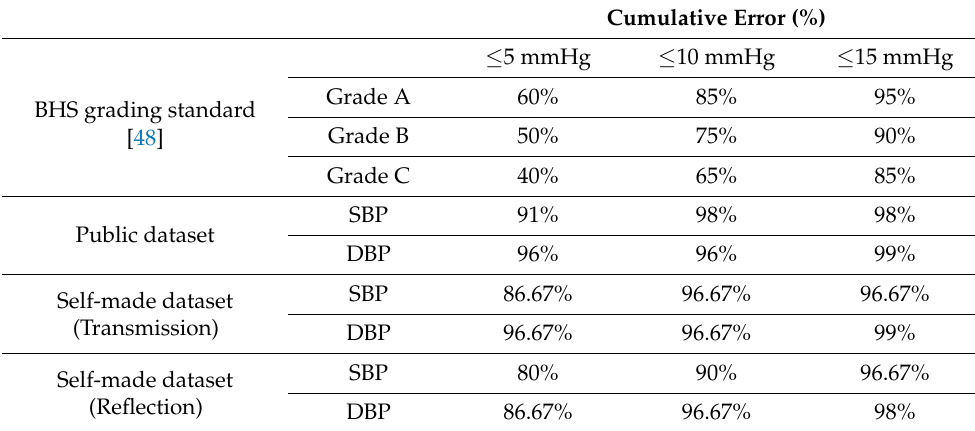
Table 13. Comparisons of the results with the BHS grading